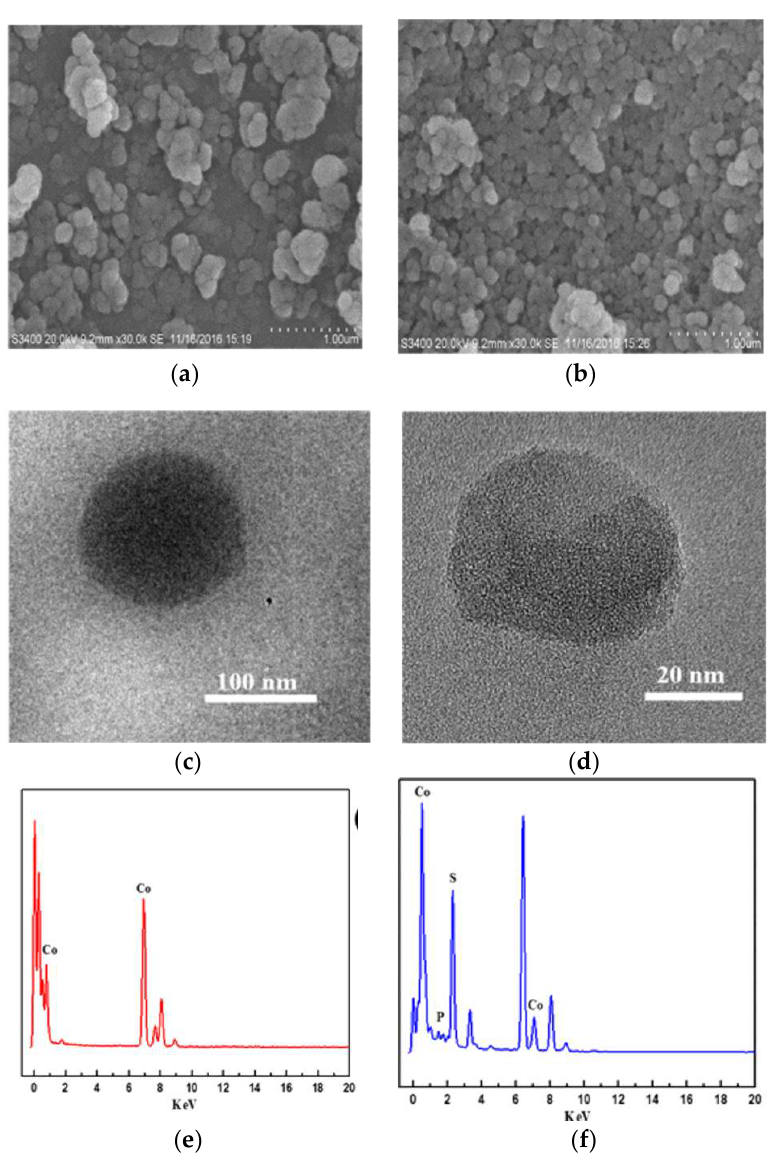
Figure 2. ( a ) SEM image of 2-Melm@MSNC; ( b ) SEM image of 2-Melm@PLA 1 /MSNC; ( c ) TEM image